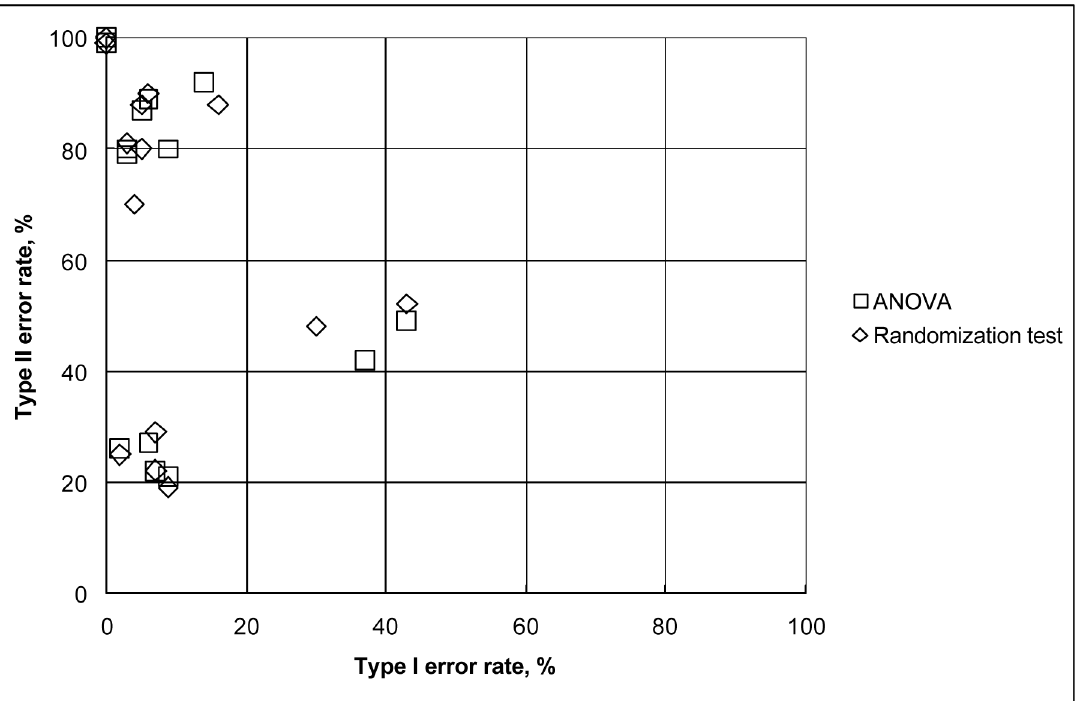
Fig. 1. Similar performance of ANOVA and randomization test with samples of different parameters (sample size and variance) and different distribution types as shown by clustered values of type I and II error rates. See Table 1 for a list of the combination of pa- rameters